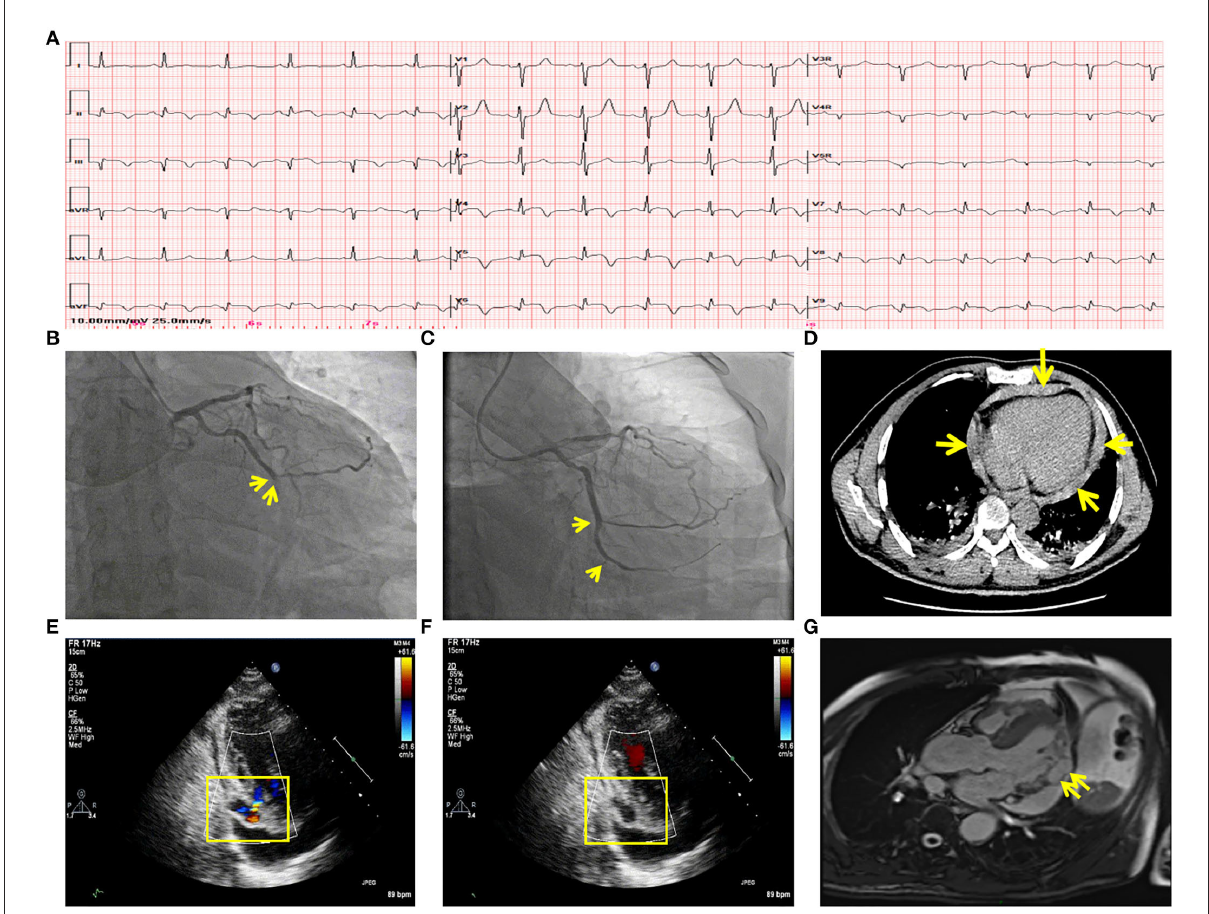
FIGURE1 Clinical data of the patient with LV pseudoaneurysm post-acute myocardial infarction. (A) ECG showed acute inferior-, posterior- and lateral wall myocardial infarction. (B) Coronary angiography showed LCX acute occlusion. Yellow arrows indicated the occluded point of the LCX. (C) The primary percutaneous coronary intervention of LCX. A yellow arrow marked the revascularization of the proximal segment of the LCX. (D) CT demonstrated hemopericardium which was marked by yellow arrows. (E) TTE showed an LV pseudoaneurysm formation and blood between the pseudoaneurysm and LV during the diastolic period. (F) TTE showed blood flow interruption during the systolic period. (G) CMR confirmed LV pseudoaneurysm formation in the lateral wall, which is marked by the yellow arrow. LV, left ventricle; ECG, electrocardiogram; LCX, left circumflex; TTE, transthoracic echocardiography; CMR, cardiac magnetic resonance